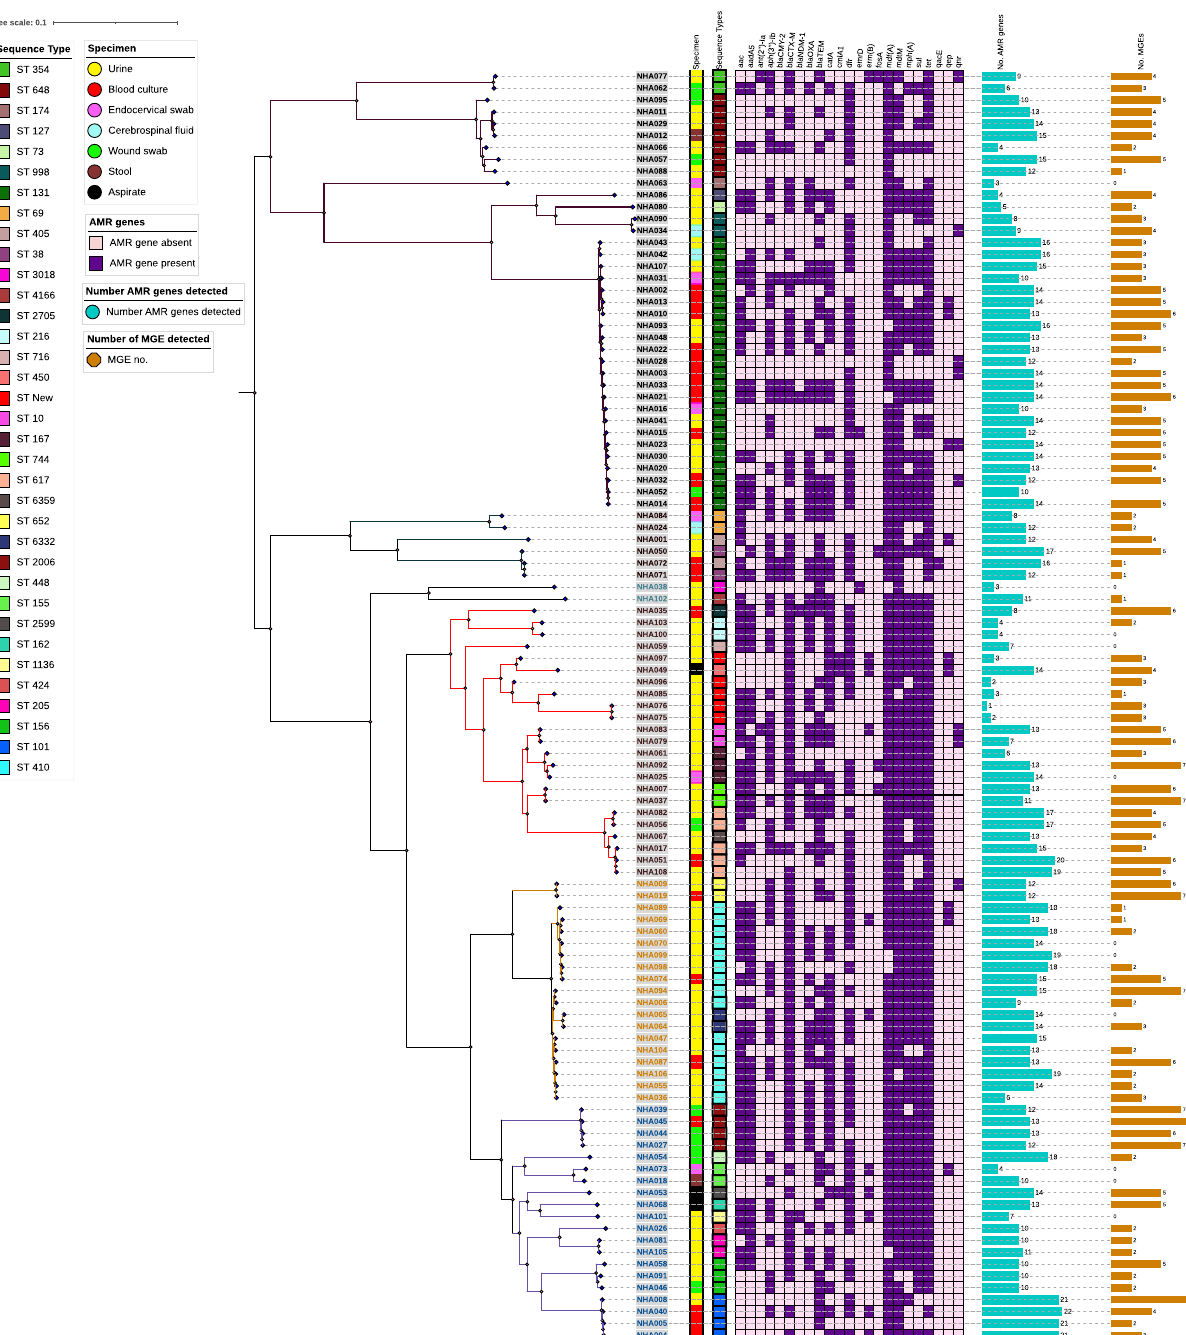
Figure 4. Phylogenetic analysis of SNPs from E. coli strains in study with colour strips of specimen source and sequence types, heat map of AMR genes, bar chart of number of resistance genes identified and bar chart of number of mobile genetic elements identified and bar chart of number of mobile genetic elements identified per isolate. Tree was midpoint rooted. The SNP was based on the reference strain